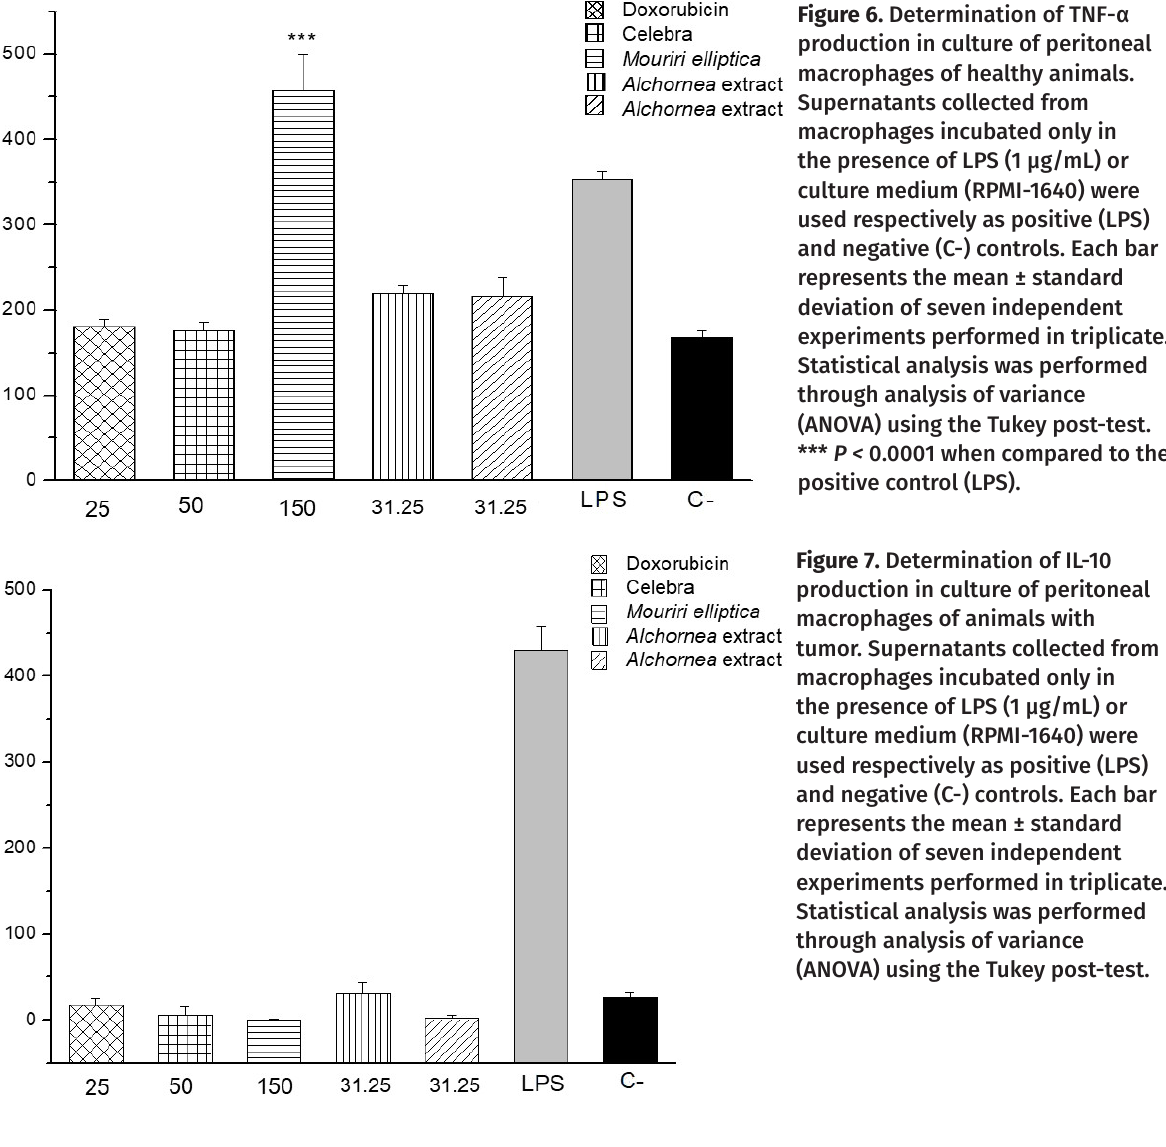
Figure 6. Determination of TNF-α production in culture of peritoneal macrophages of healthy animals. Supernatants collected from macrophages incubated only in the presence of LPS (1 μg/mL) or culture medium (RPMI-1640) were used respectively as positive (LPS) and negative (C-) controls. Each bar represents the mean ± standard deviation of seven independent experiments performed in triplicate. Statistical analysis was performed through analysis of variance (ANOVA) using the Tukey post-test. *** P < 0.0001 when compared to the positive control (LPS). Figure 7. Determination of IL-10 production in culture of peritoneal macrophages of animals with tumor. Supernatants collected from macrophages incubated only in the presence of LPS (1 μg/mL) or culture medium (RPMI-1640) were used respectively as positive (LPS) and negative (C-) controls. Each bar represents the mean ± standard deviation of seven independent experiments performed in triplicate. Statistical analysis was performed through analysis of variance (ANOVA) using the Tukey